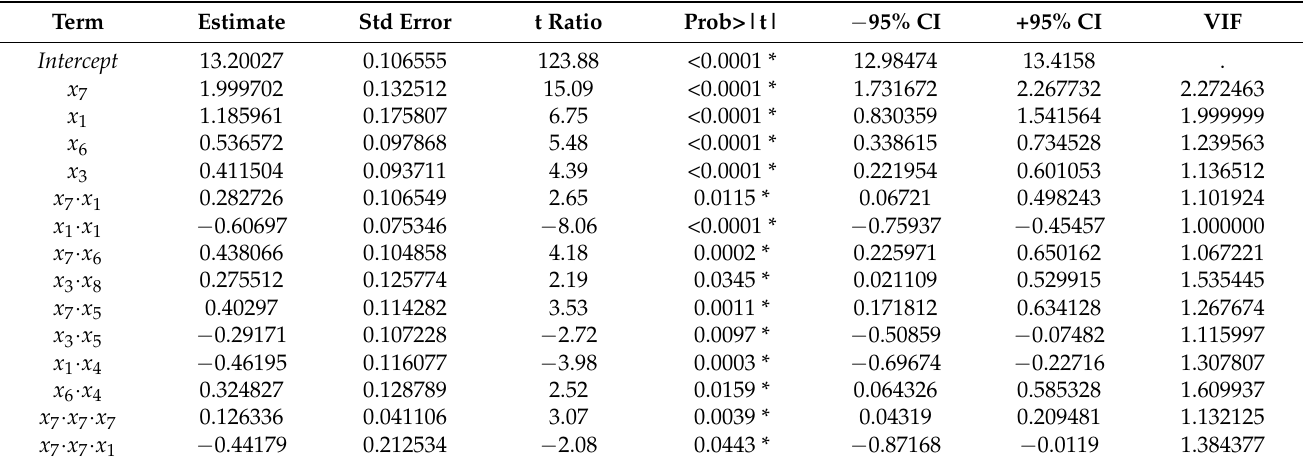
Table 5. The estimation of regression coefficients of the developed nonlinear model predicting the zinc coating thickness ( t h